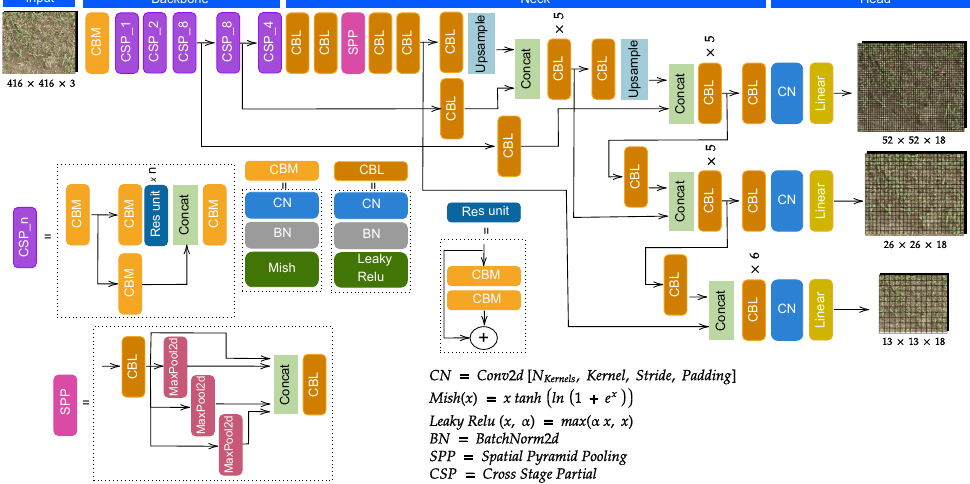
Figure 5. Diagram of the YOLOv4 architecture with an input image of 416 × 416 pixels and 3